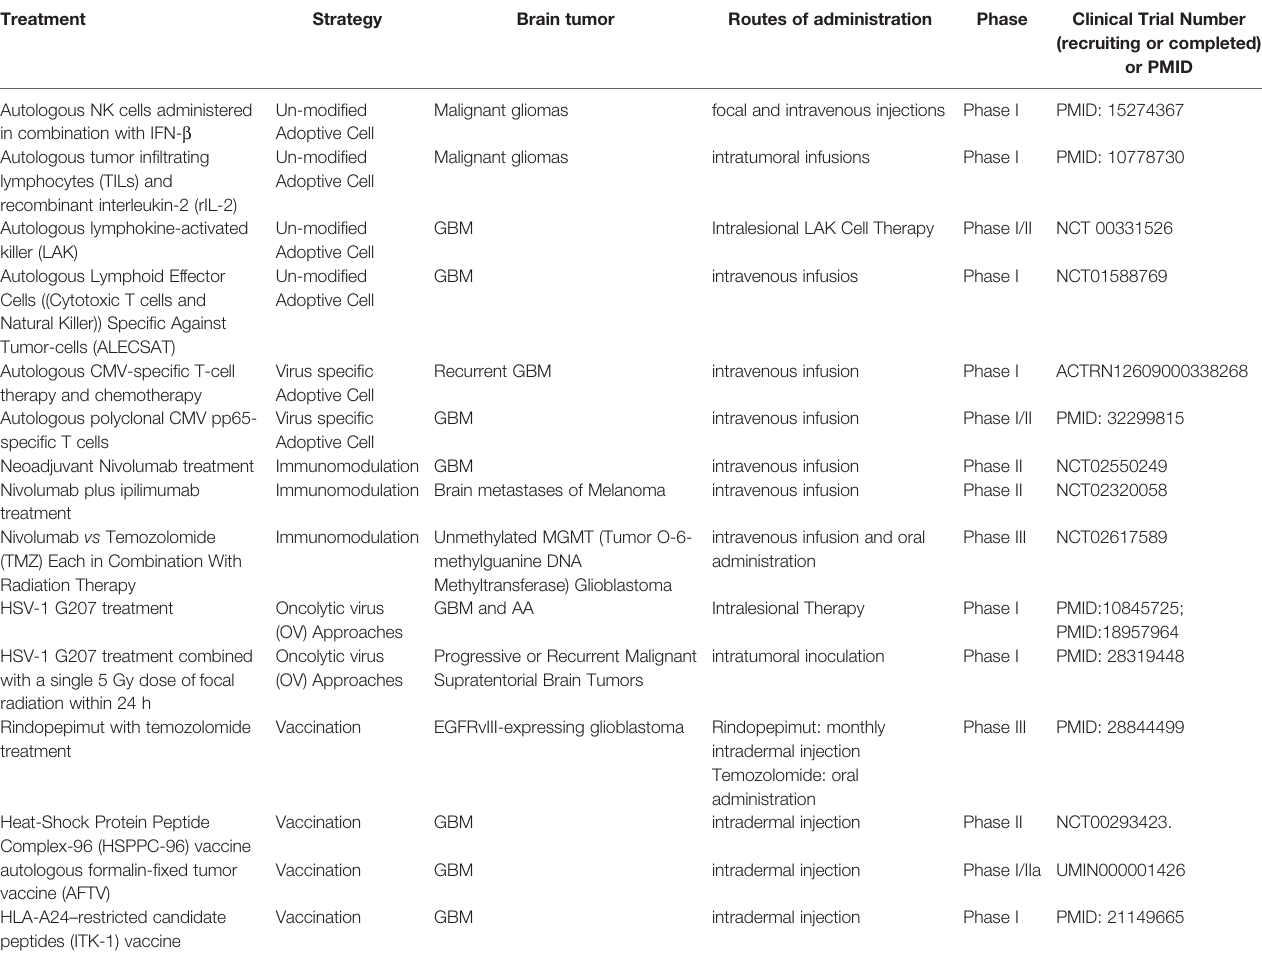
TABLE 1 | Summary of recruiting or completed clinical trials covering brain tumor immuno-therapeutic